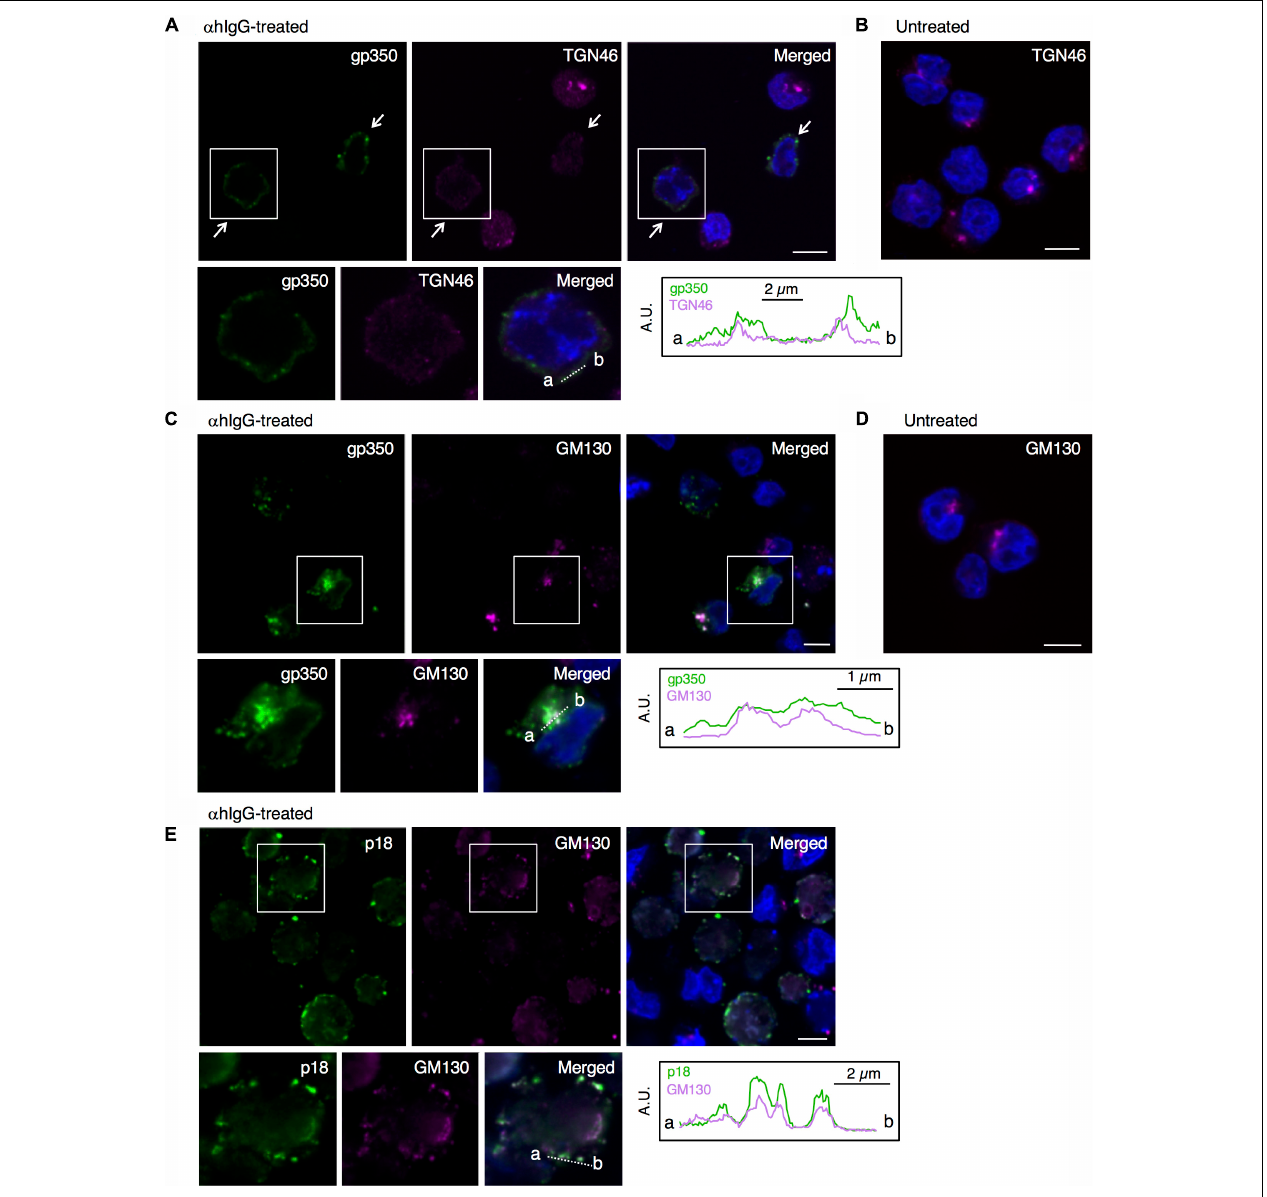
FIGURE 5 | EBV structural proteins distribute in the compartments containing cis- Golgi and the TGN markers. The distribution of the EBV structural proteins and markers of Golgi apparatus in Akata + cells induced into the lytic cycle. Akata + cells were treated with α hIgG (A,C,E) or without (B,D) for 16 h. (A) The distribution of gp350/220 (left), TGN64 (middle) and merged (right) images are shown. As a control, the distribution of TGN64 in the untreated cells is shown in (B) . (C) The distribution of gp350/220 (left), GM130 (middle) and merged (right) are shown. As a control, the distribution of GM130 in the untreated cells is shown in (D) . (E) The distribution of the EBV capsid antigen, p18 (left) and GM130 (middle) and merged (right) images are shown. The nuclei (blue) were counterstained with Hoechst 33342. Insets show the boxed areas. The plots indicate the individual fluorescence intensity along each of the corresponding lines. A.U., arbitrary unit. Scale bars: 10 µ